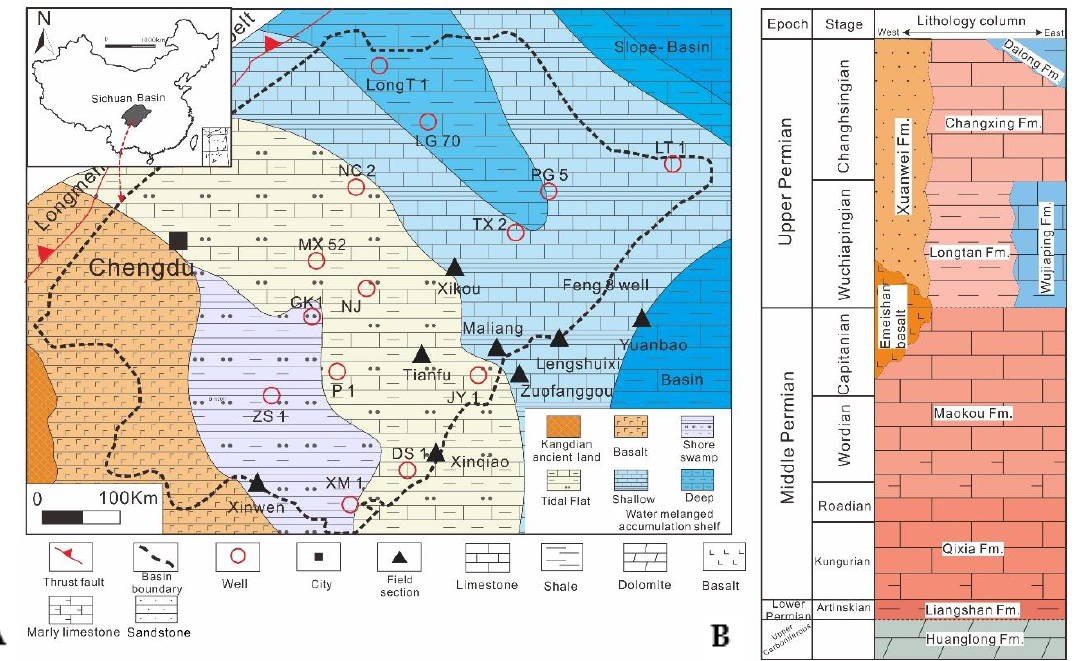
Figure 1. ( A ) The geological setting and the paleogeographic maps of the Longtan Formation of the Sichuan Basin; ( B ) Simplified stratigraphic column of the Permian in the Sichuan Basin.